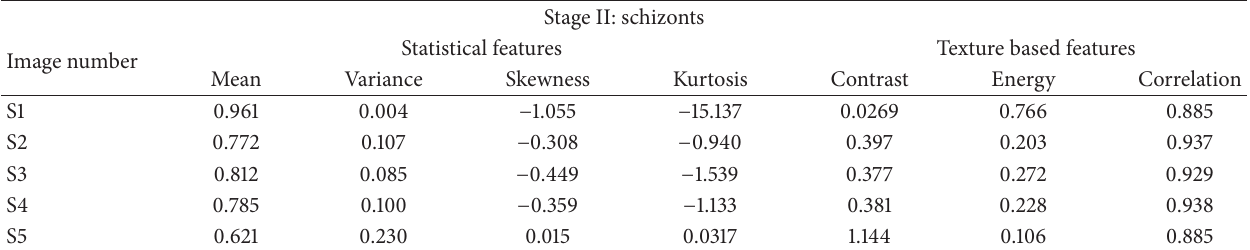
Table 2: The values obtained while training dataset for stage II.